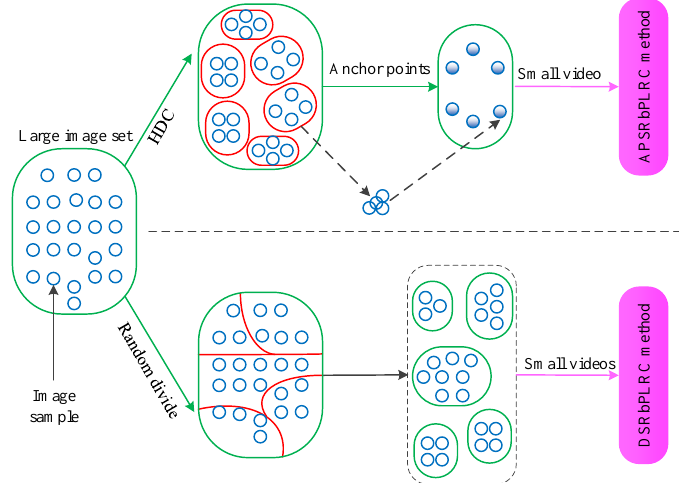
Figure 3. An illustration of the proposed DSRbPLRC and APSRbPLRC algorithms. DSRbPLRC directly divides a large-size video into several small-size sub-videos, and each sub-video is used for classification. Different from DSRbPLRC, APSRbPLRC uses the HDC algorithm to extract anchor points, which will not increase the number of